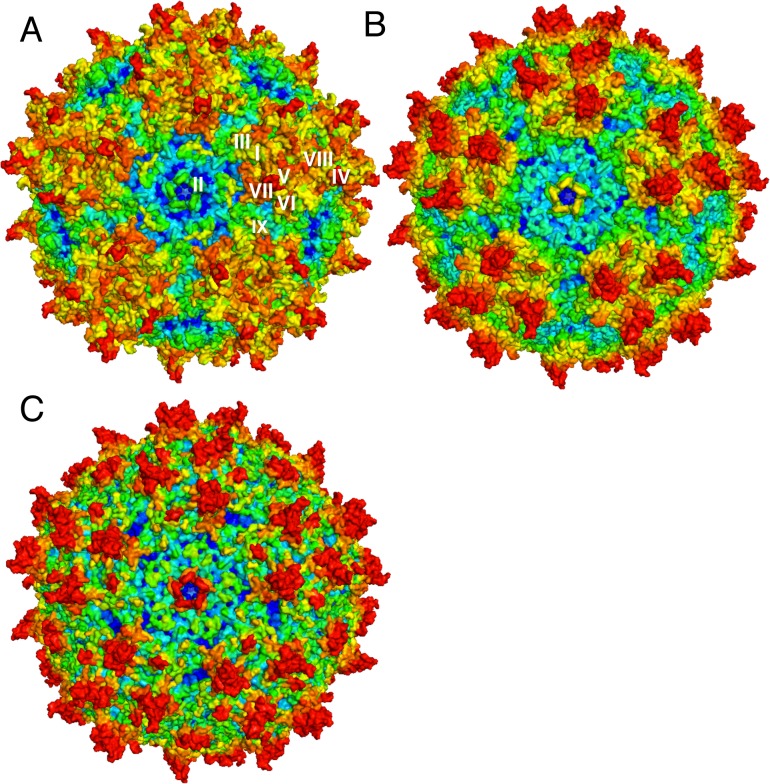
The capsid crystal structure of the AAV serotype 8 (AAV8) in three surface representations.(A) the conservation-colored structure, on which the variable loop regions I-IX are labeled, (B) the c-distance-colored structure and (C) the WCN-colored structure.